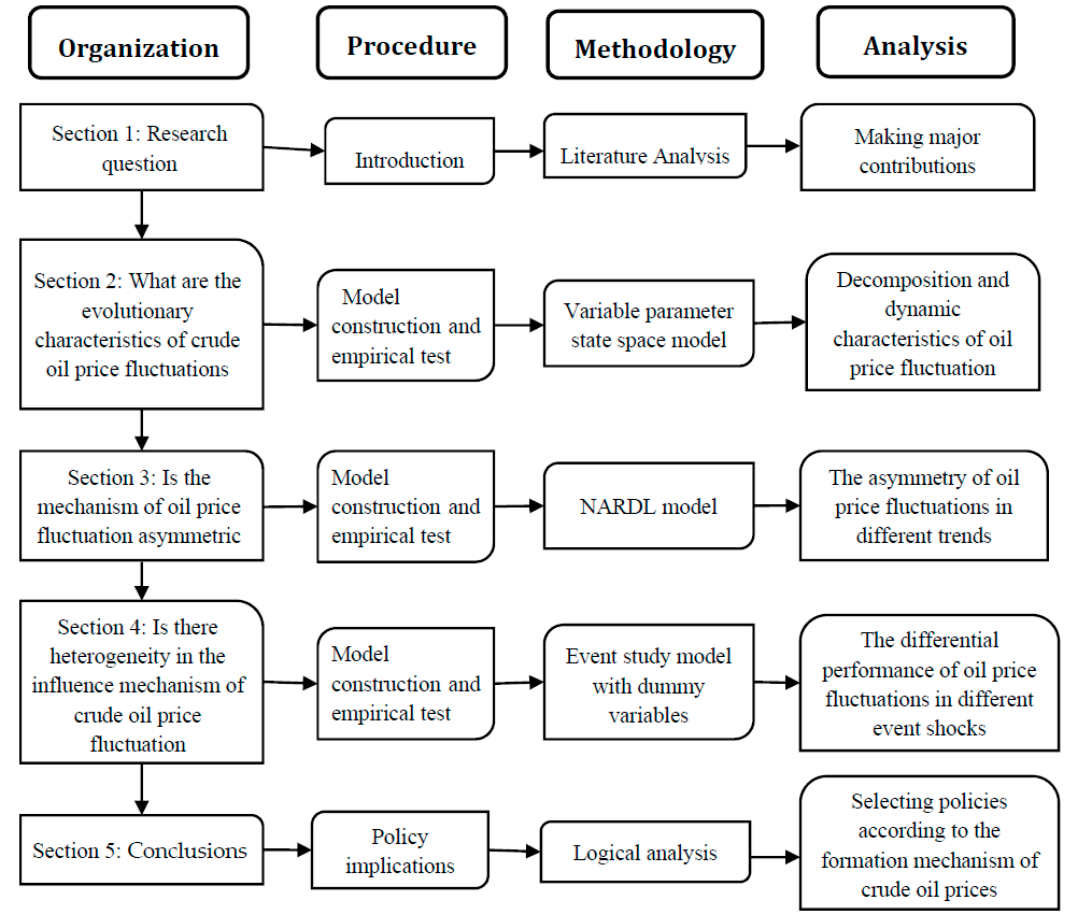
Figure 1. The logical framework of this paper.